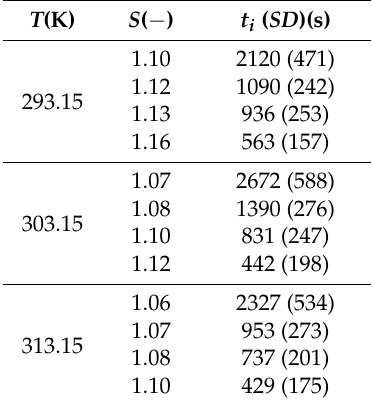
Table 1. The average induction times and the corresponding standard deviations (SD) for L-Glycine. T (K) S ( − ) t i ( SD )(s)